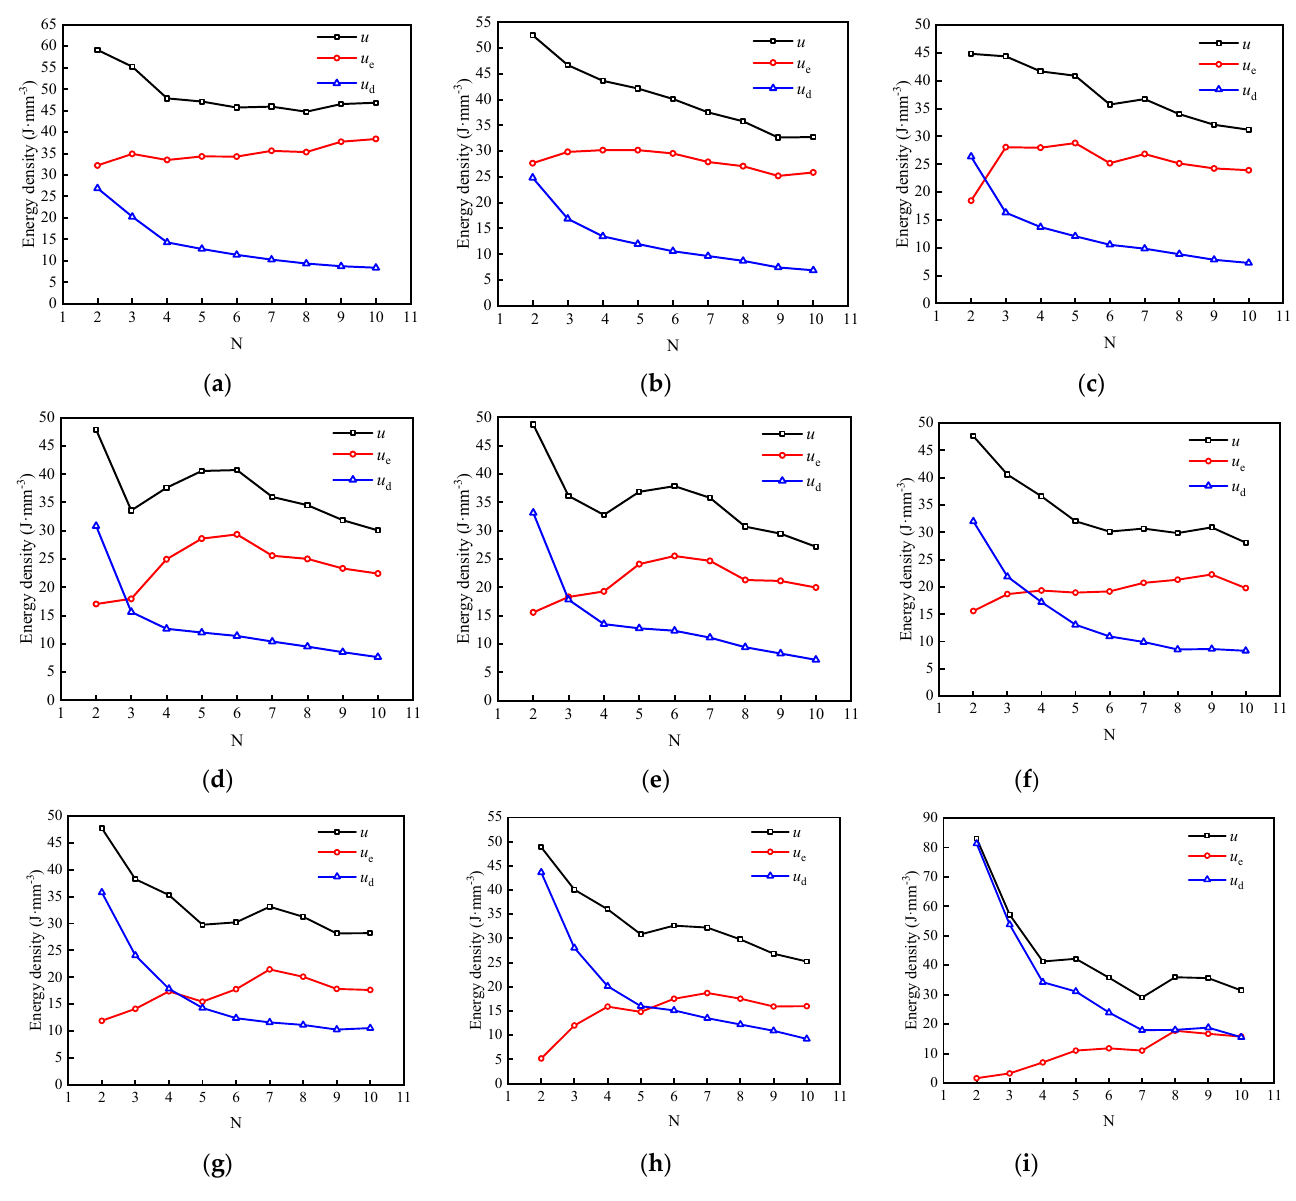
Figure 6. Variations in energy density of specimen 4–6.52 with the number of cycles N under various cyclic stresses: ( a ) 1.35 MPa; ( b ) 1.80 MPa; ( c ) 2.25 MPa; ( d ) 2.70 MPa; ( e ) 3.15 MPa; ( f ) 3.60 MPa; ( g ) 4.05 MPa; ( h ) 4.50 MPa; ( i ) 4.95 MPa. According to the actual failure strength of the sample, the cyclic stress is normalized, and the energy density of the last nine cycles under all levels of cyclic stress is averaged to obtain the relationship between the average energy density and the stress level (the ratio of the upper limit of cyclic stress at all levels to the actual failure strength of the sample, as shown in Table 4), as shown in Figure 7. With the increase in stress, the energy